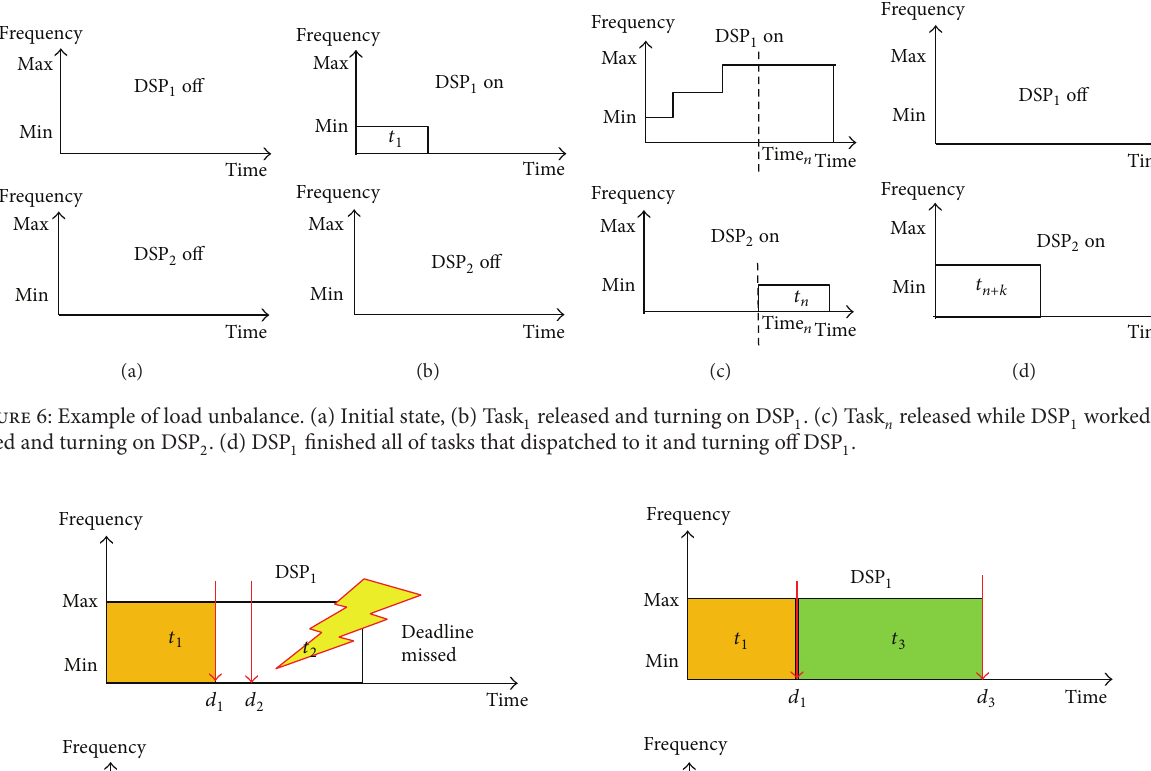
Figure 7: Example of real-time tasks dispatch. (a) Distribution of task deadlines is uneven. (b) Distribution of task deadlines is uniform.